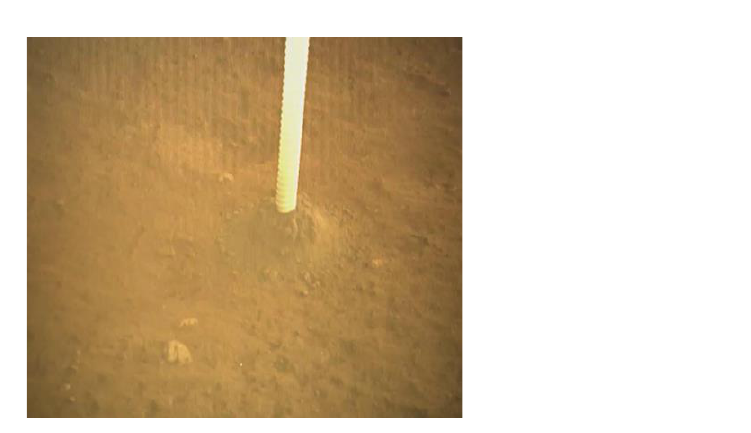
Figure 3. The scene of drilling taken by the monitor camera installed at the bottom of the Lander.